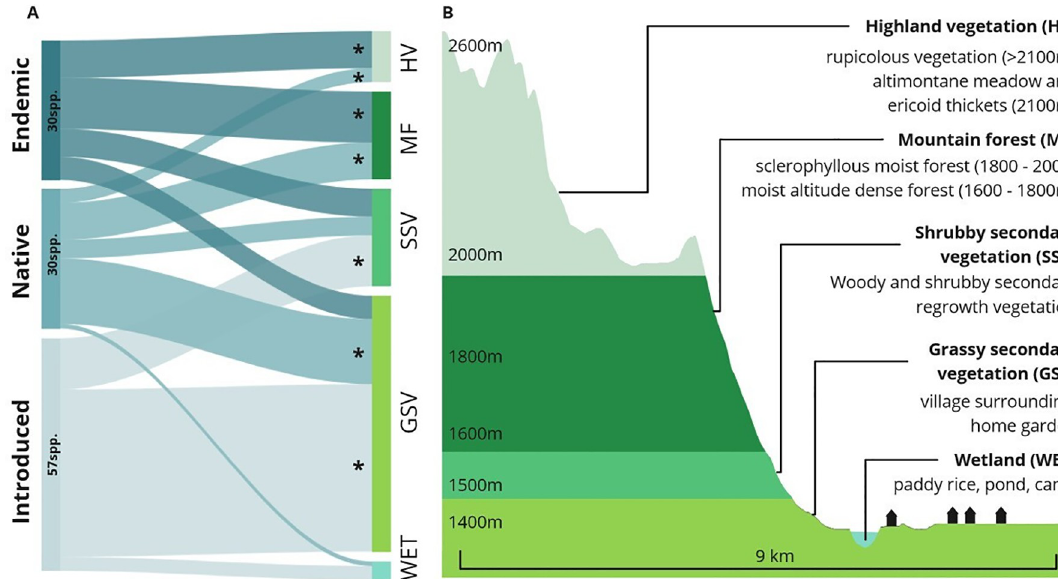
Fig 2. Biogeography and habitat of Betsileo WEPs collection. A. Sankey diagram showing the proportion of endemic, native and introduced WEP species found in each habitat. The thickness of the lines refers to the number of species. “ � ” indicate significant relation based on MANOVA (threshold at P < 0.001) (S2 Table in S1 File). B. altitudinal zonation of vegetation in Namoly valley from west to east. X and Y axes not at the same scale.